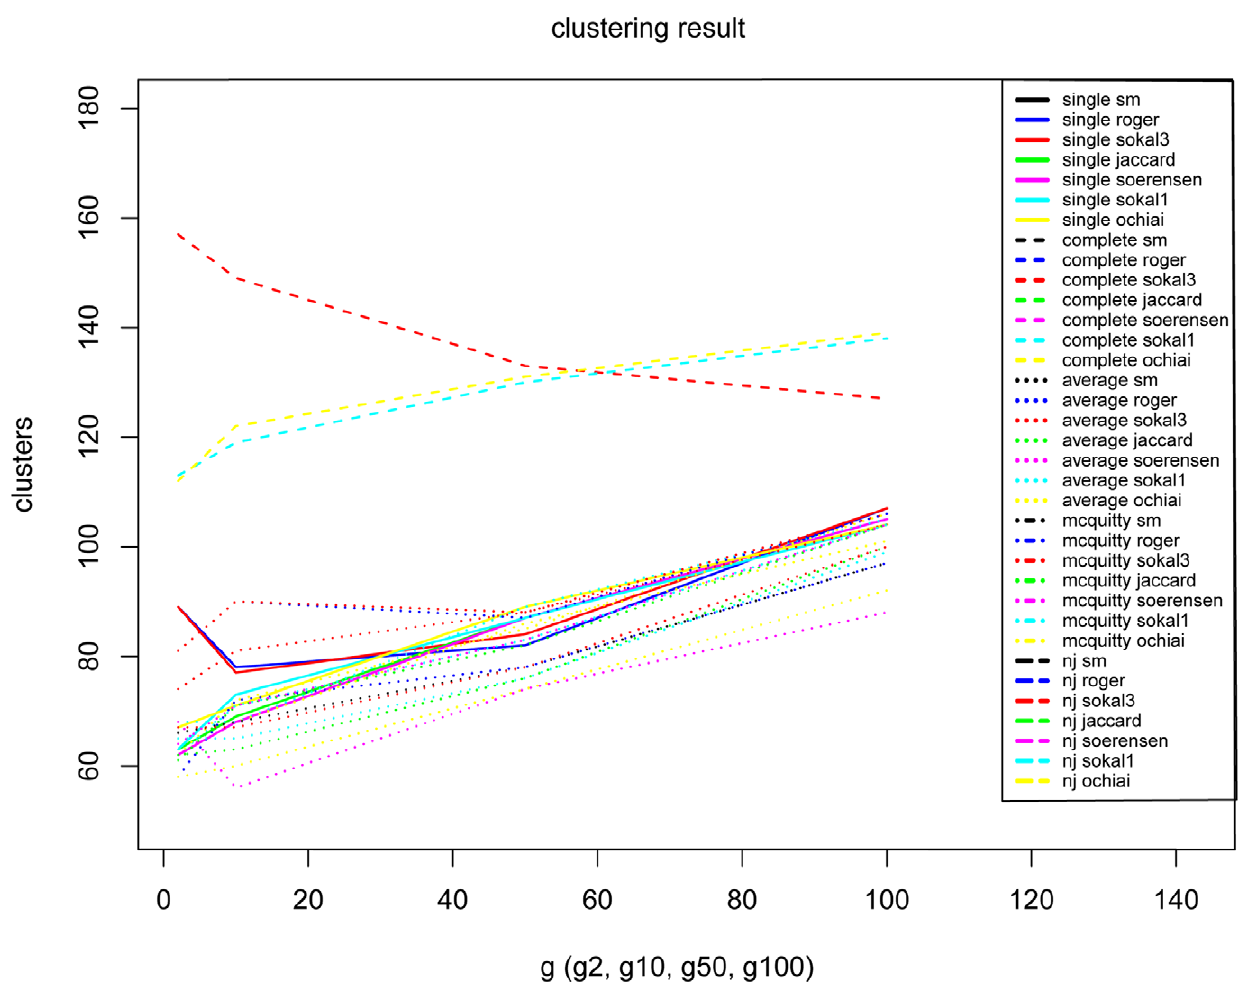
Figure 4. Variation of number of returned clusters based on clustering method and term occurrence in articles.